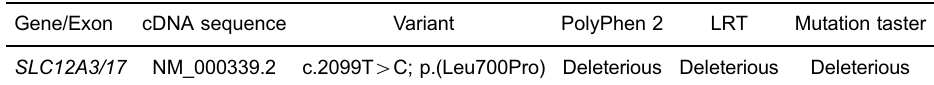
Table 2. In silico analysis results from three prediction tools of the novel genetic mutation in SLC12A3